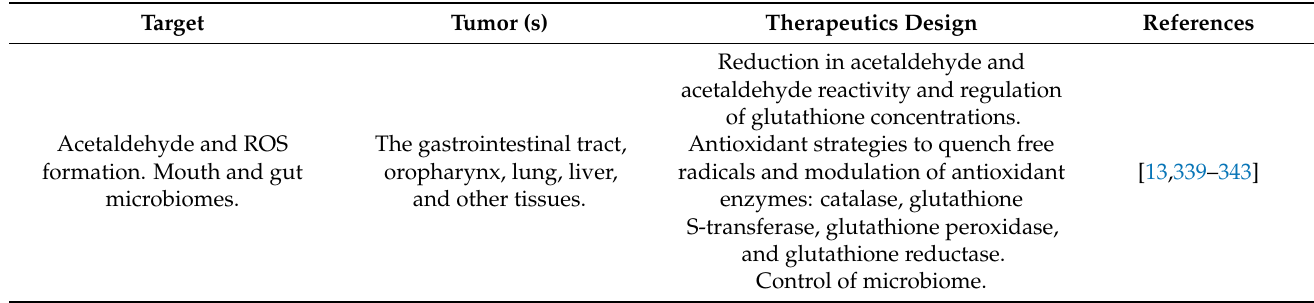
Table 4. Representative examples of candidate targets for developing new treatments to reverse ethanol’s damaging effects on cell development, proliferation, and metabolism homeostasis associated with cancers.